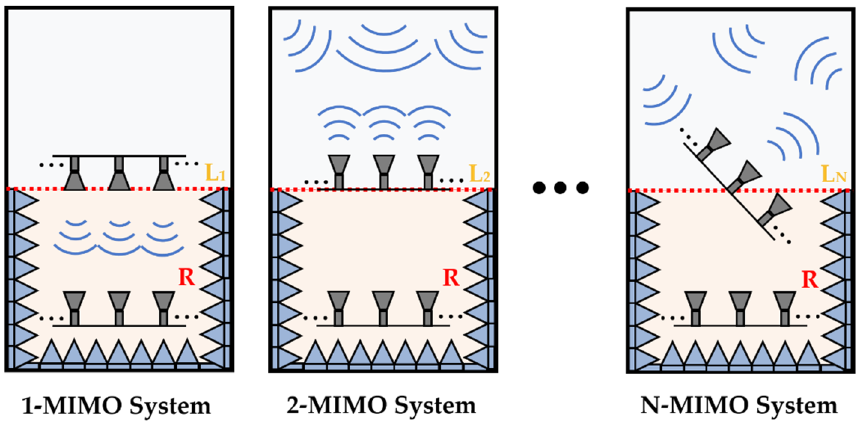
Figure 2. Scheme of a D-MIMO consisting of a set of MIMO subsystems acquired in a semi-anechoic and semi-reverberation chamber.